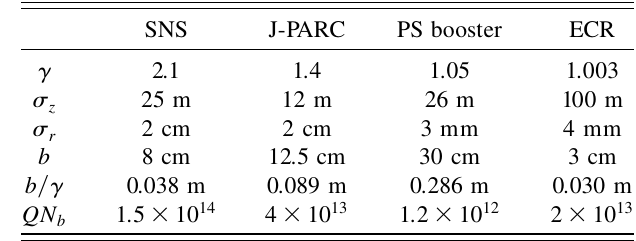
TABLE IV. Example